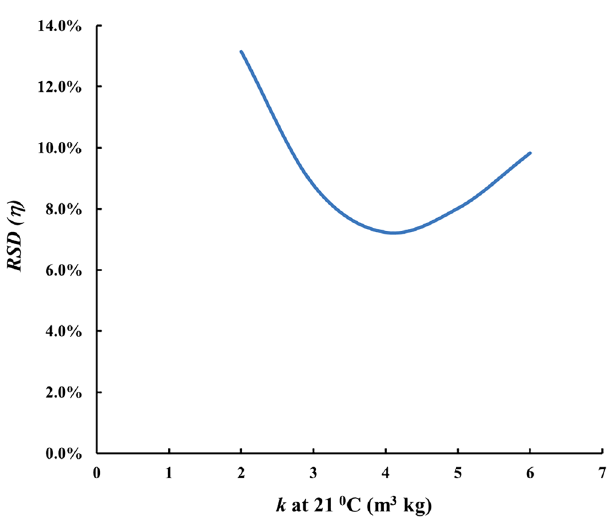
Figure 8. Relative standard deviation in η over 5–35 °C as dependent on k for the module from Fig.